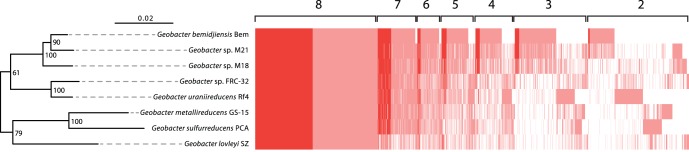
Distribution and expression of orthologous proteins across eight Geobacter genomes.Pink shading illustrates the presence of orthologous proteins within genomic data, while red shading indicates expression of an orthologous protein by an environmental Geobacter strain, identified using predicted peptides from G. bemidjiensis. Values along the top of the chart indicate the number of Geobacter strains the orthologs are distributed over. For the core proteome (as identified by orthologs present in all eight Geobacter genomes), ∼47% expression is detected within biomass recovered from the Rifle subsurface. The data is coupled to a neighbor-joining tree constructed using 16S rRNA sequences from eight sequenced Geobacter genomes, and illustrates the correlation between inferred evolutionary distance and the distribution of orthologous proteins.